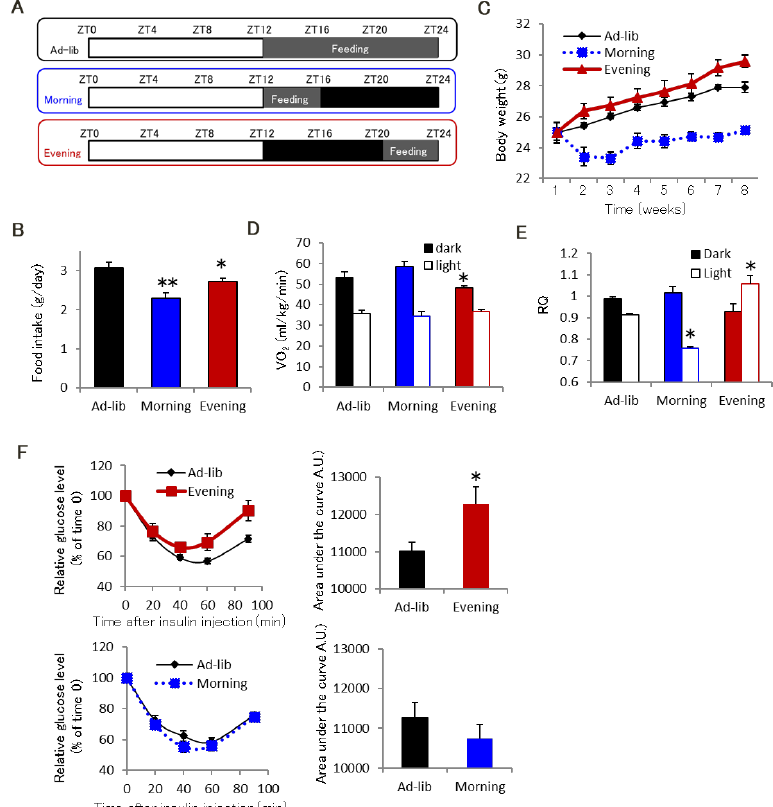
Figure 1. Evening feeding leads to whole body insulin resistance. ( A ) Feeding schedule for this study. ( B ) Food intake in the Morning and Evening groups was lower than in the Ad-lib group ( n = 8 – 11). ( C ) Body weight in the Ad-lib and Evening groups, but not the Morning group, gradually increased ( n = 8 – 11). ( D and E ) Respiratory analysis indicated that the Evening group ( n = 6) had decreased VO 2 ( D ) and increased RQ ( E ). ( F ) Relative glucose levels (left) after injection of insulin (1 U/kg) in the Evening group (ZT4, upper), in the Morning group (ZT20, bottom) with the respective Ad-lib group. The Evening group ( n = 6) had a significantly greater area under the curve (right) than the Ad-lib group. Right panels are the area under the curve of respective ITT. Data are presented as mean ± standard error. * p < 0.05, ** p < 0.01 vs. Ad-lib group.